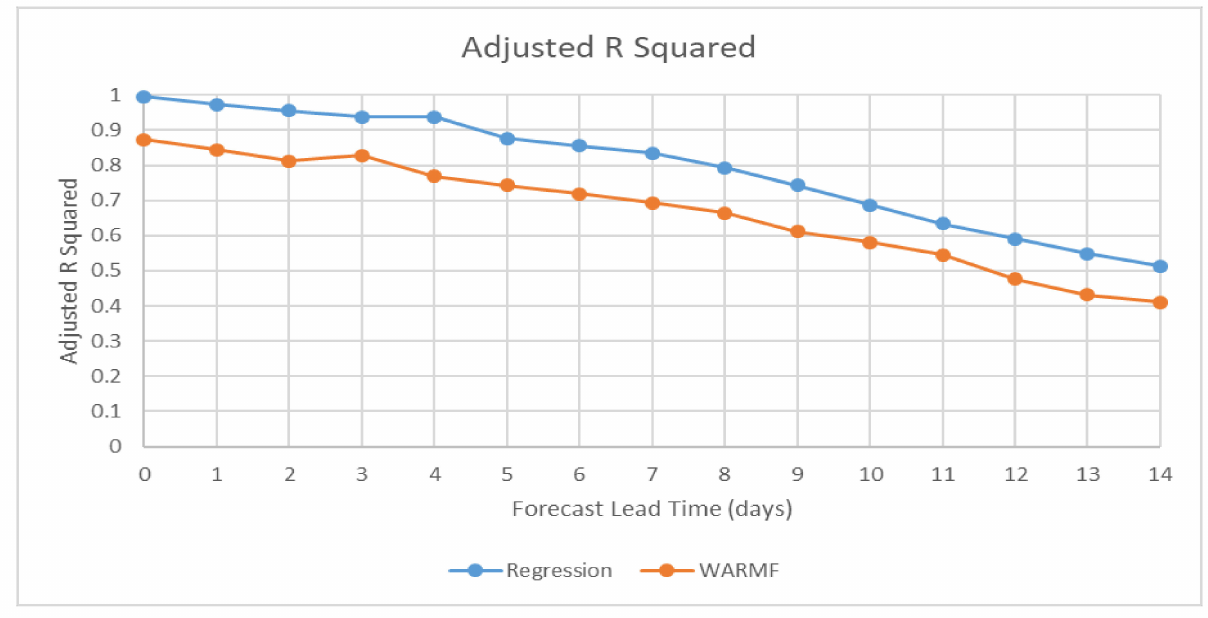
Figure 16. Adjusted R-squared values for the Regression and WARMF models for all EC forecast lead